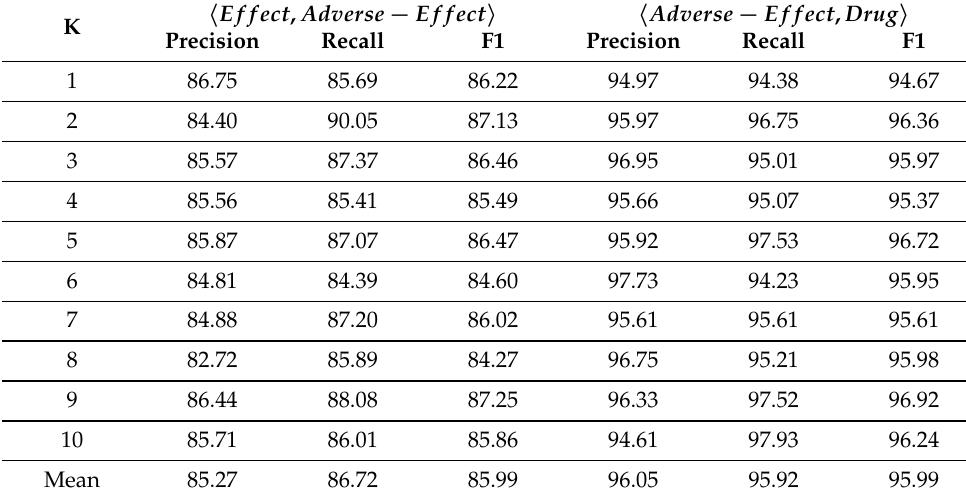
Table 6. Detailed experimental results on the ADE